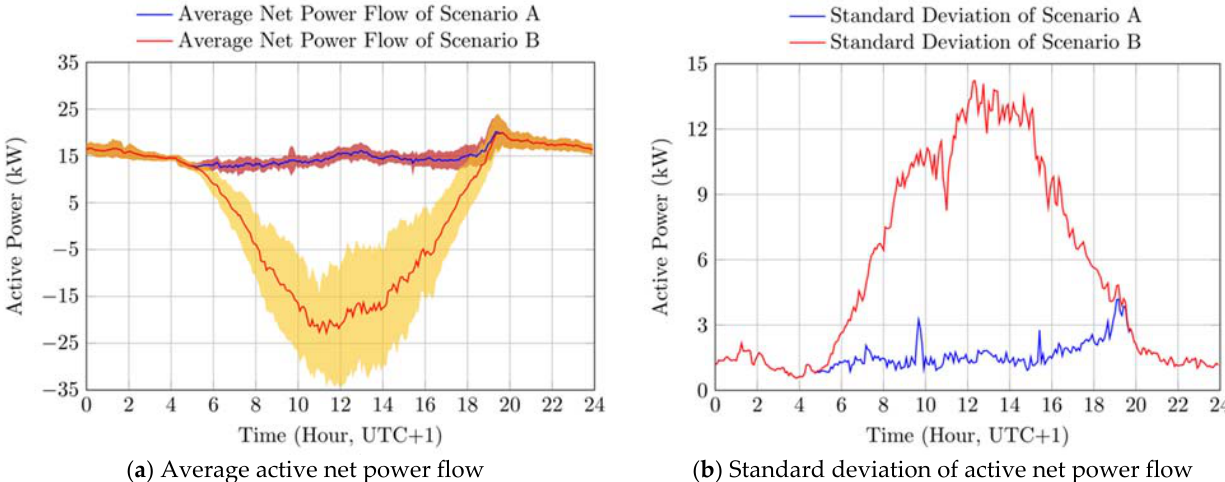
Figure 5. Active net power flow at the PCC with the main grid for Scenarios A and B during May 2020. In sub-figure ( a ), the red and yellow areas represent the standard deviation of the measurements for each i -th time interval for scenarios A and B, respectively. The latter are reported in detail in sub-figure ( b ). UTC: universal time